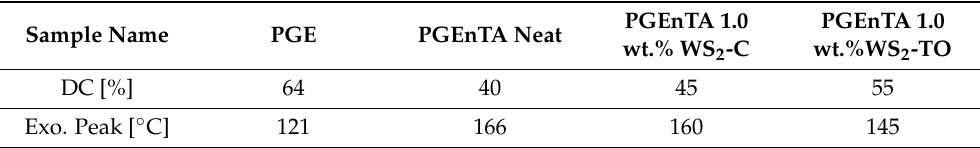
Table 2. The degree of conversion (DC) and the exothermic peak temperature of thermally cured composite and neat epoxy/acrylate